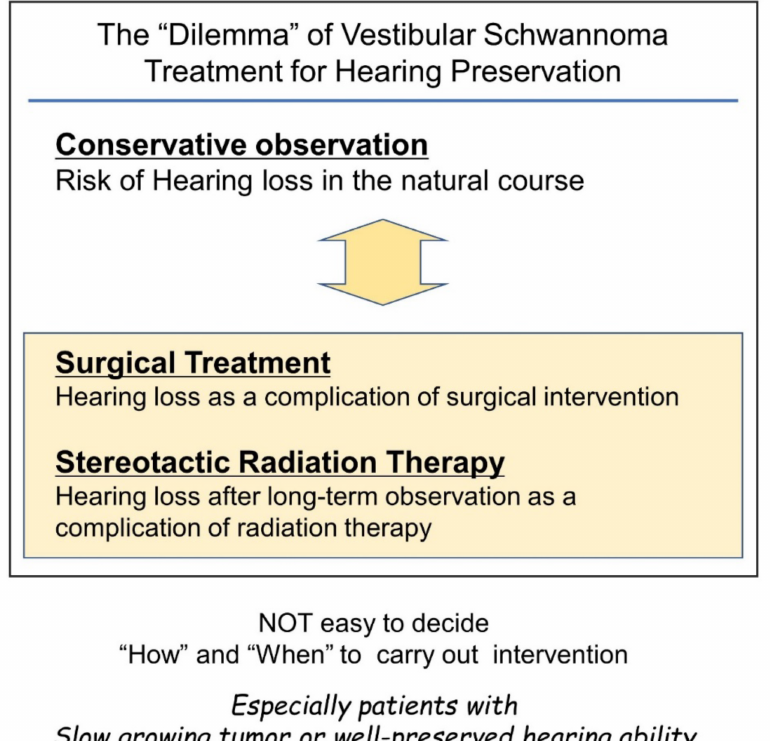
Figure 1. Difficulties in timing considerations in vestibular schwannoma intervention with the goal of preserving hearing. Conservative observation and intervention with surgery or stereotactic radiotherapy can cause hearing loss. Therefore, the decision to intervene can be a difficult decision for the